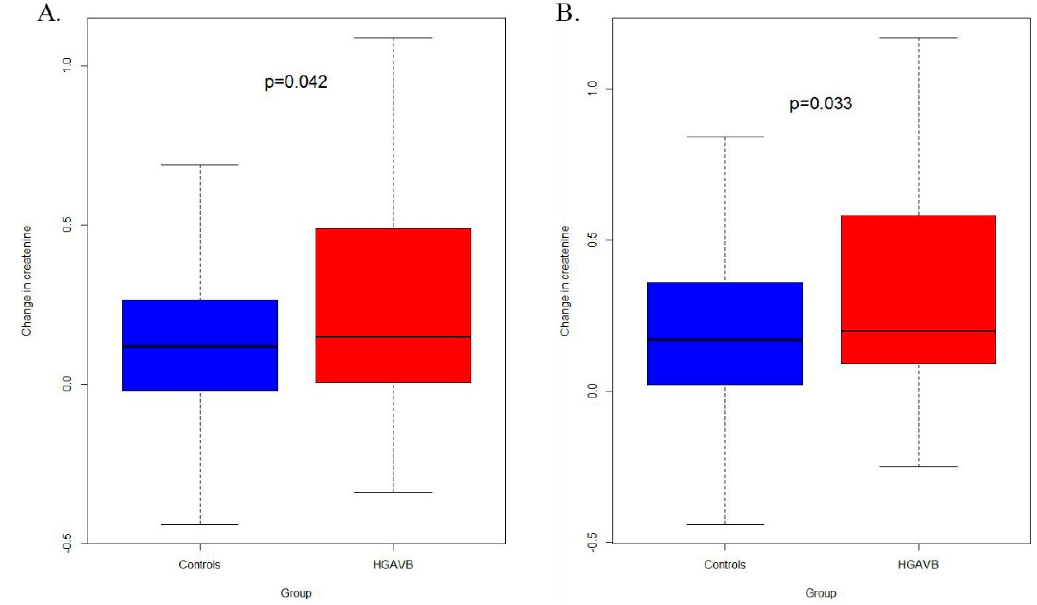
Figure 3. Box plots of change in creatinine level in mg/dL between groups of HGAVB and controls between ( A ) baseline creatinine and admission creatinine, and ( B ) baseline creatinine and maximum level of creatinine during hospitalization.